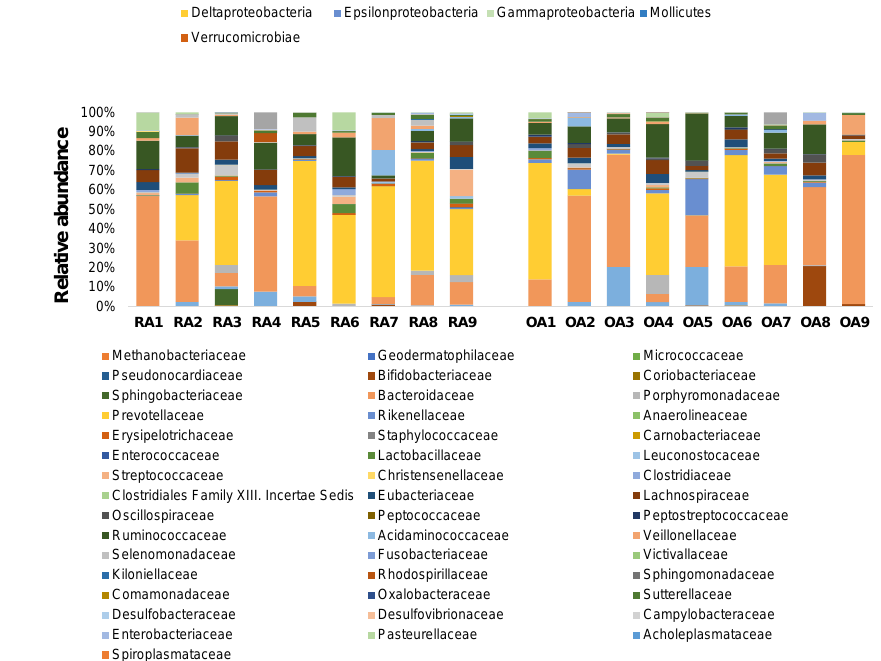
Figure 4. Stacked bar graphs for the relative abundance of bacterial 16S rRNA from fecal samples of rheumatoid arthritis (RA1–9) and osteoarthritis (OA1–9) patients at the ( A ) phylum, ( B ) class, and ( C ) family